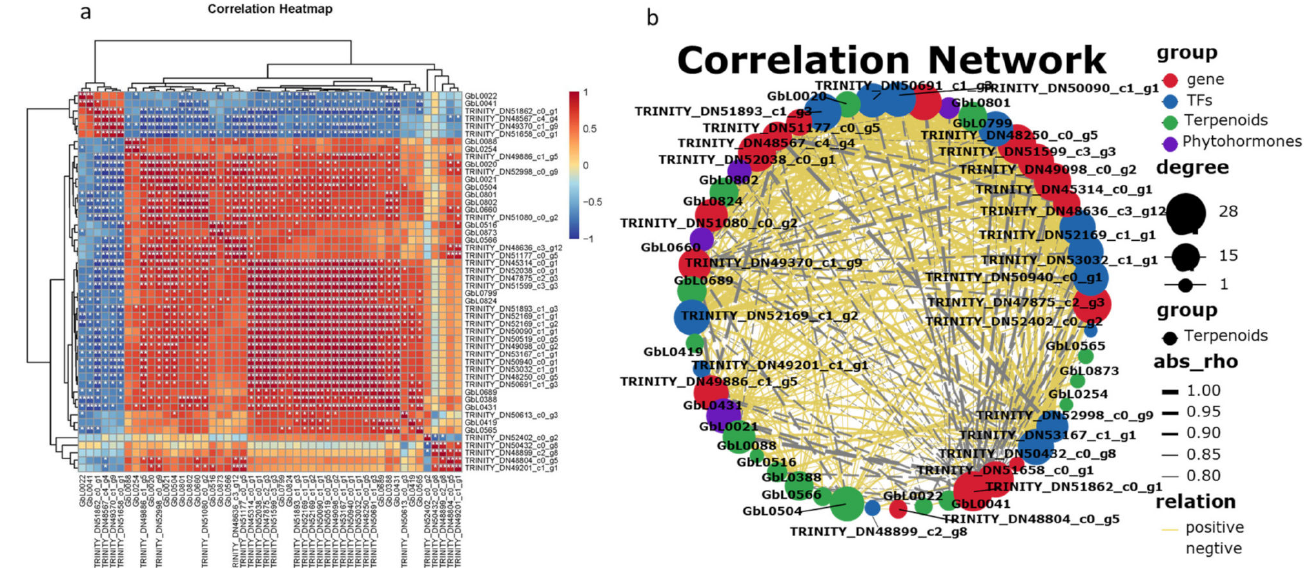
Figure 8. Correlation analysis between differentially expressed genes and metabolites that are related to terpene synthesis in ginkgo leaves. ( a ) Correlation clustering heat map between core differential metabolites and differentially expressed genes; ( b ) correlation network diagram between ginkgolides, differential hormones, and hot genes. ** represents very significant level; * represents significant